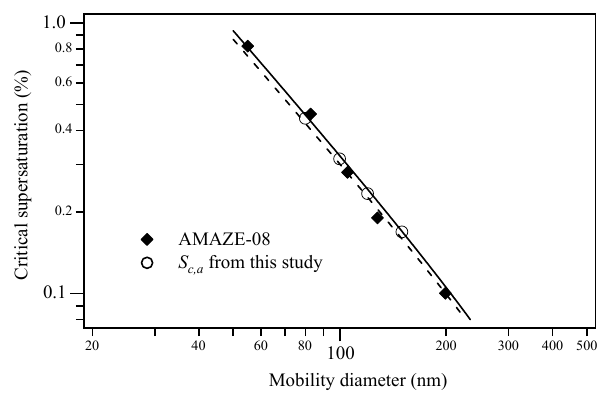
Fig. 6. Size-resolved critical supersaturations measured during AMAZE-08 (diamonds) compared to apparent critical supersatura- tions S c , a that can be predicted using the results of the present study (open circles). The predictions use Eq. (1) and the parameters of Ta- ble 2. The linear fit of all S c , a is shown as the solid line. The dashed line represents a similar analysis for S c , a predicted using the prop- erties of secondary organic material formed by the dark ozonolysis of α -pinene (dashed line) (King et al., 2007,